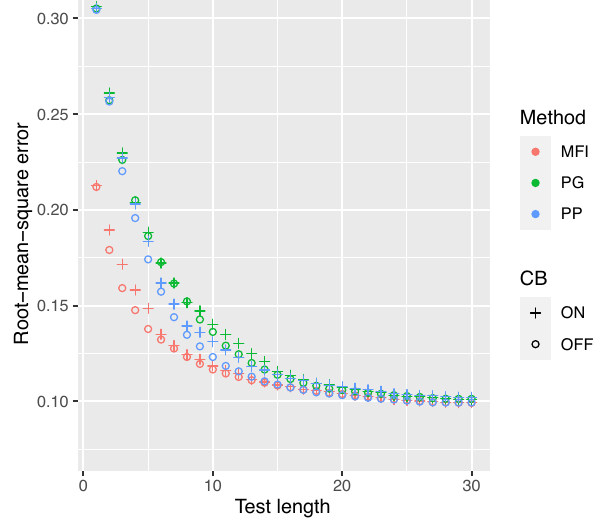
FIG. 2. Comparison of the effects of test security algorithms on RMSE (maximum Fisher information, red; progressive, green; proportional, blue). The class size is 40 and the test length of the pre- and post-test is fixed to be the same. The plus symbol shows the result with content balancing and the circle symbol shows the result without content